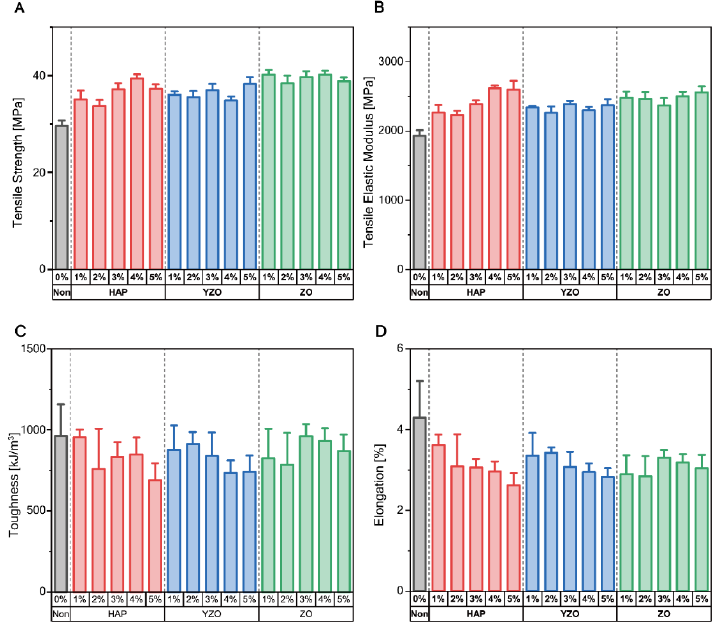
Table 3. Result of the tensile test by type of bioceramic–epoxy composite material.